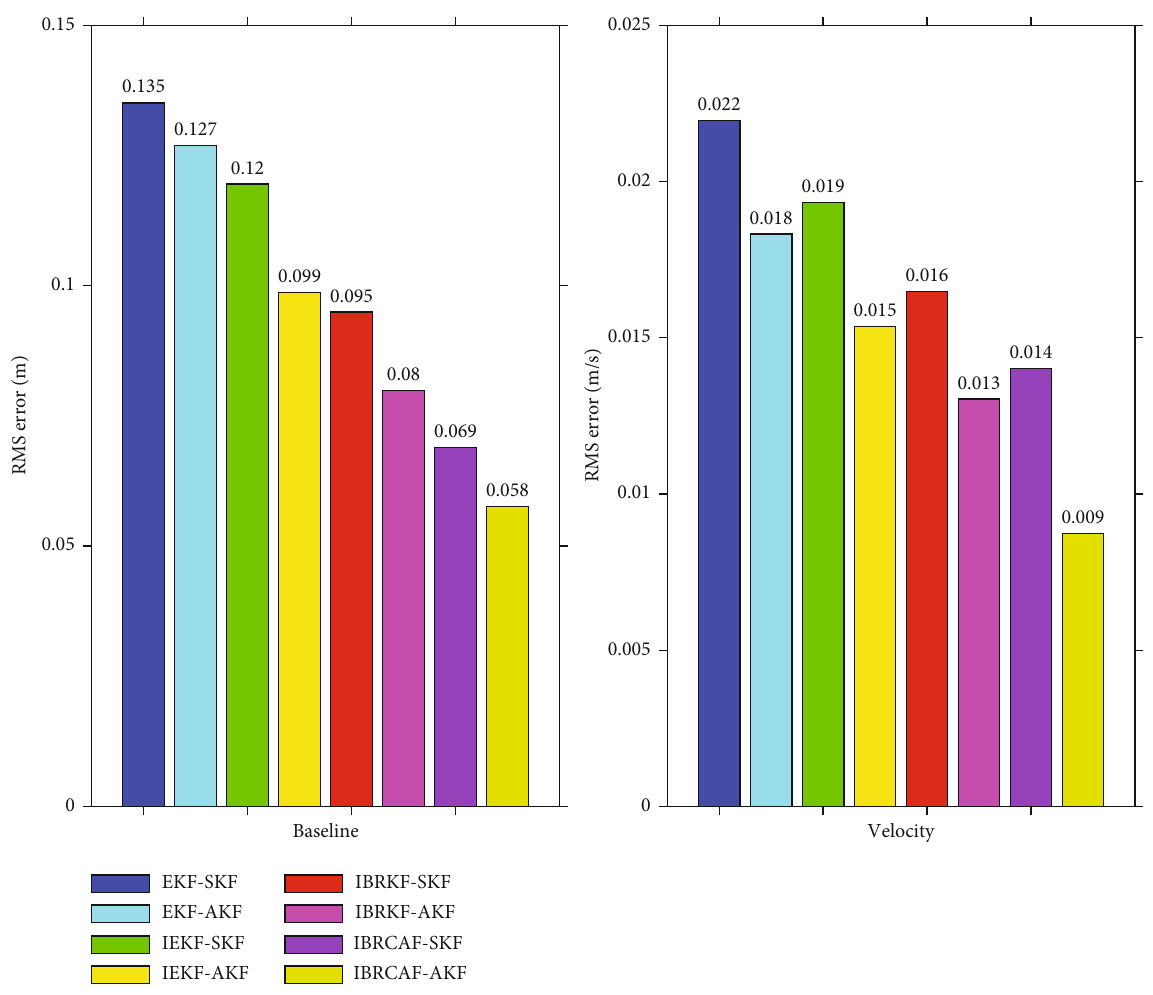
Figure 21: The RMS errors of baseline and velocity of various algorithms for Data